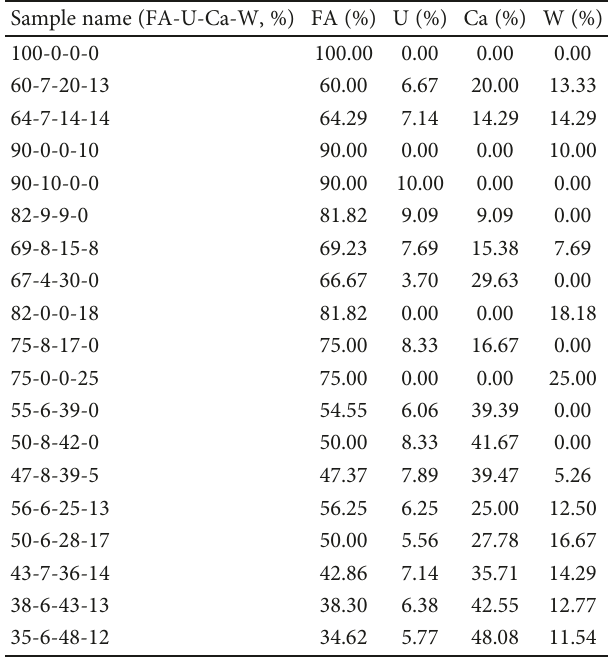
Table 1: Ingredients for the solutions (in some cases, the sum is not 100% — due to the mathematical rounding of the numbers — the names are only for